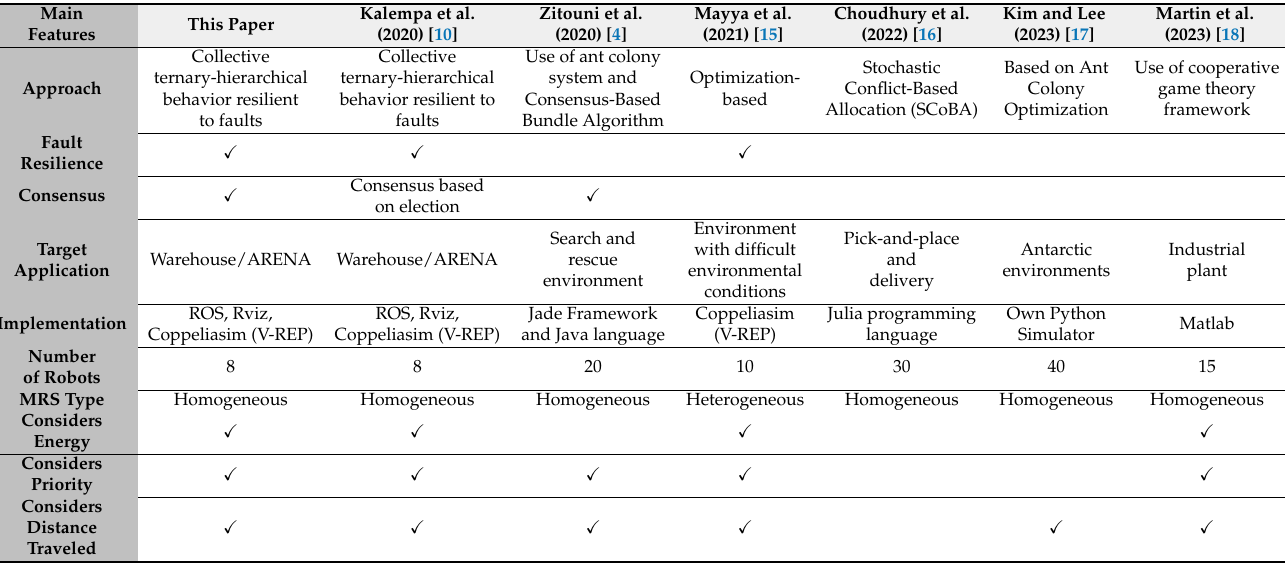
Table 2. Comparison with related works—Part